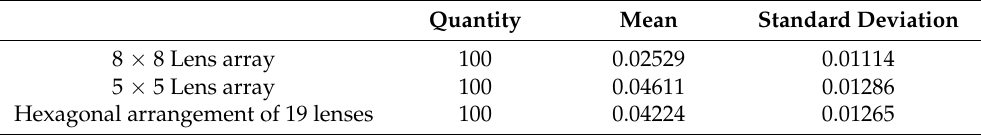
Figure 7. Reconstruction accuracy of different combination aberrations by three arrangement meth- ods: ( a ) random combined aberrations; ( b ) combined aberrations with certain weights. Table 3. Reconstruction accuracy statistics of 100 random combination aberrations by three arrange- ment methods.